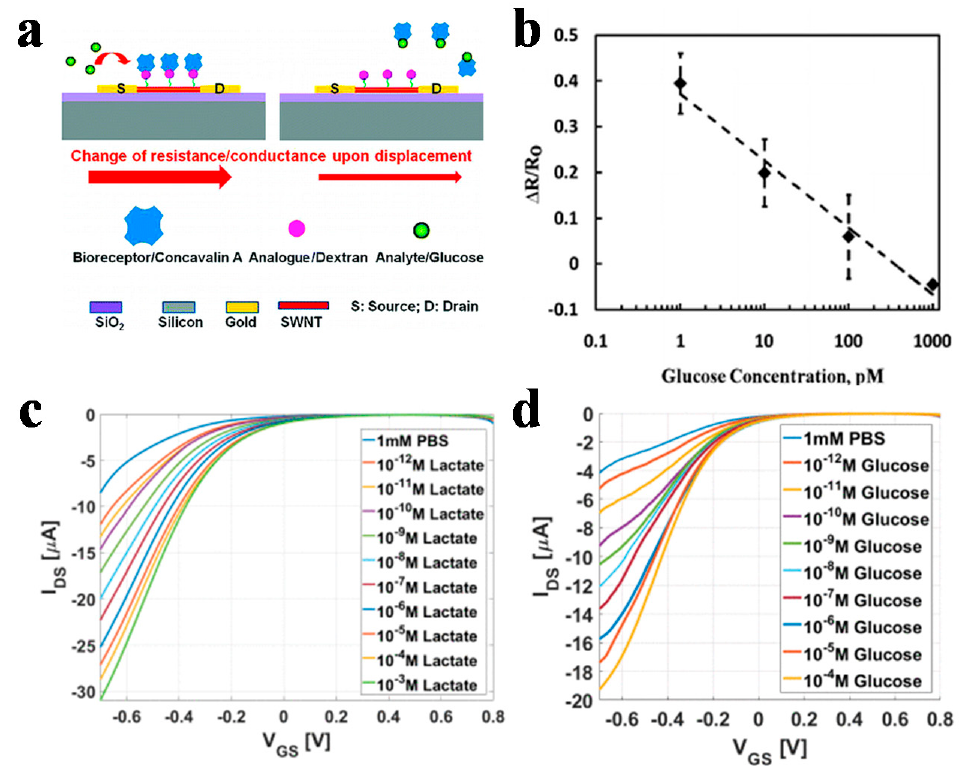
Figure 4. CNTFET-based H 2 O 2 sensor. ( a ) Schematic of a CNTFET for glucose sensing via the detec- tion of H 2 O 2 and ( b ) its relative resistance change in response to different glucose concentrations [54]. The change of current of CNTFETs in response to ( c ) different lactate and ( d ) glucose concentrations via enzymatic reactions with H 2 O 2 as a by-product [55].